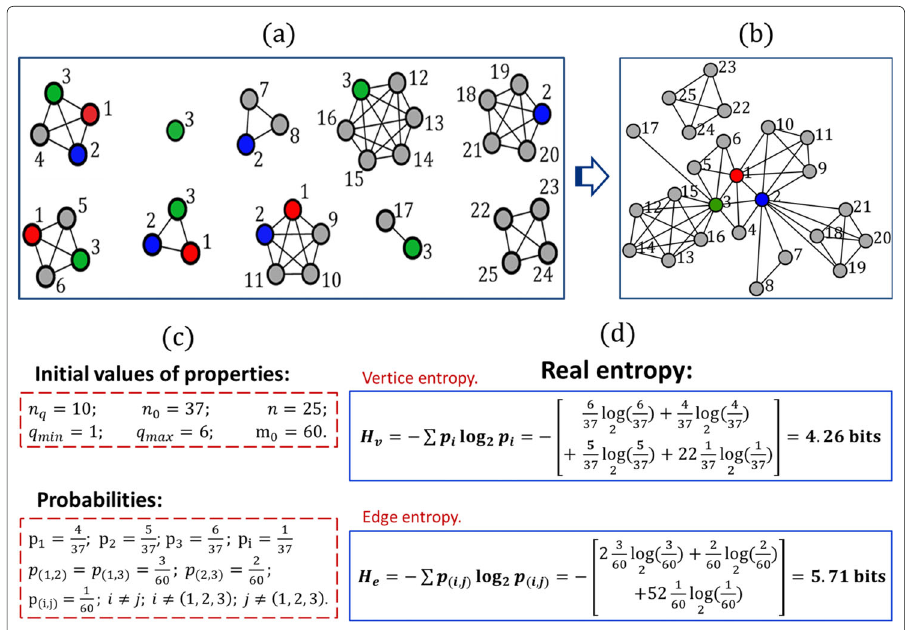
Fig. 4 Example of a network of cliques in its formation process, the associated probabilities and the entropy values of its vertices and edges. In ( a ) the cliques in the initial configuration. In ( b ) the network of cliques (final configuration) built by juxtaposition and overlapping processes. In ( c ) initial values of properties and the probabilities of vertices and edges. In ( d ) the entropy values of vertices and edges for the initial